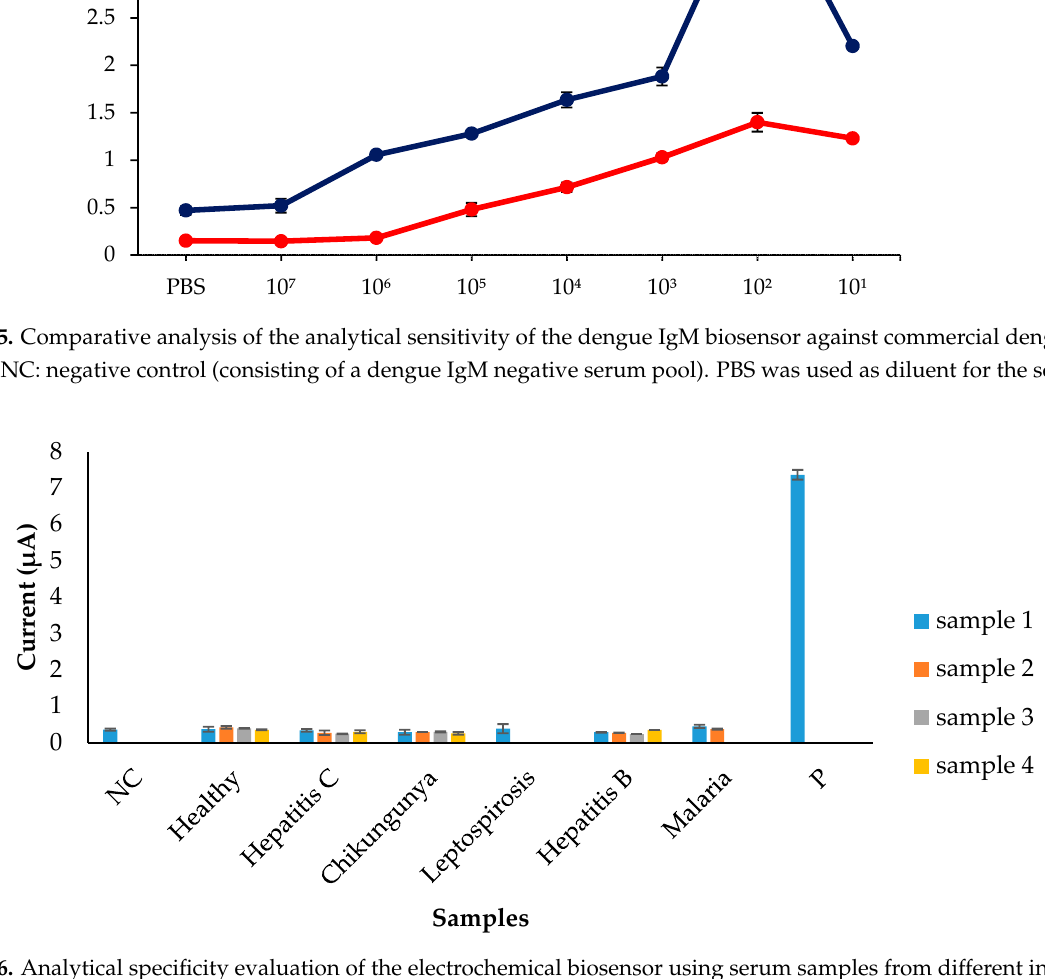
Figure 5. Comparative analysis of the analytical sensitivity of the dengue IgM biosensor against commercial dengue IgM ELISA. NC: negative control (consisting of a dengue IgM negative serum pool). PBS was used as diluent for the serum.